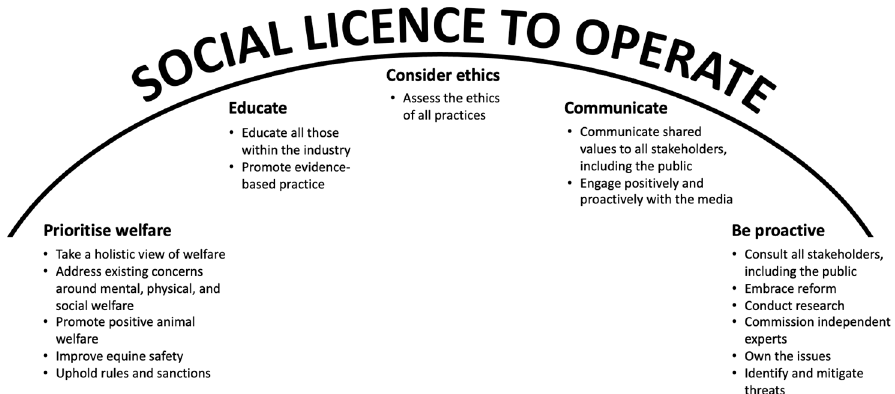
Figure 3. Actions that help to maintain an industry’s social licence to operate. The approach taken by an industry/group to its operations largely dictates the status of its social licence. Those industries that are able to pursue their activities with minimal formalised restrictions generally take a proactive approach to challenges, educate all stakeholders, and communicate well. If animals are involved in the activity, prioritisation of ethics and welfare is also important in maintenance of social licence. Industries that fail to take these steps invite regulation and/or legislation that controls or bans their activities.